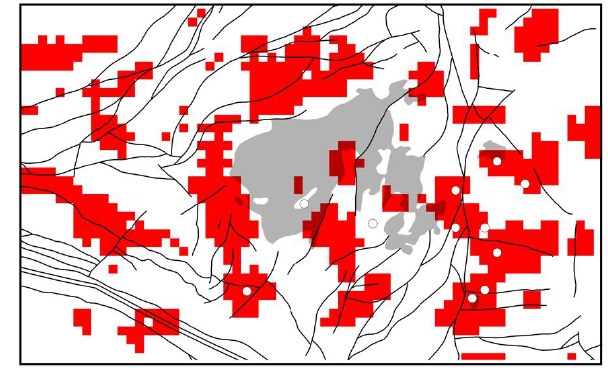
Fig. 4 Simplified geology of Gejiu mineral district. Pink polygons distributed in the center of the study area stand for Gejiu Batholith of felsic intrusions, yellow Fig. 4. Simplified geology of Gejiu mineral district. Pink polygons polygons for Gejiu formation of limestone, black lines represent faults, white distributed in the center of the study area stand for Gejiu Batholith areas for other sedimentary rocks, and dots for Sn mineral deposits. of felsic intrusions, yellow polygons for Gejiu formation of lime- stone, black lines represent faults, white areas for other sedimentary rocks, and dots for Sn mineral deposits.